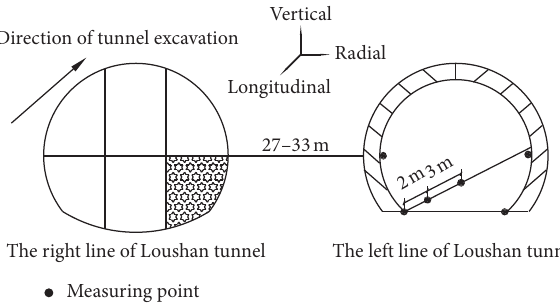
Figure 6: Layout of measuring points.